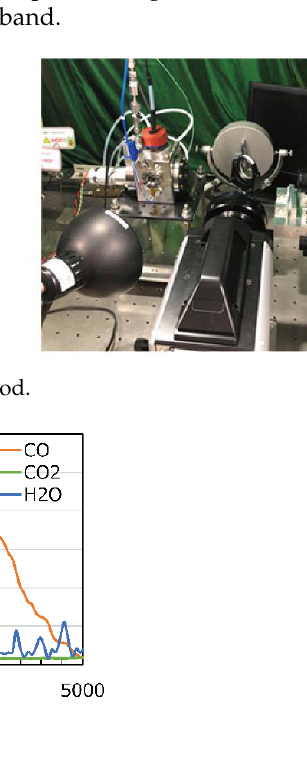
Figure 4. IR absorbance